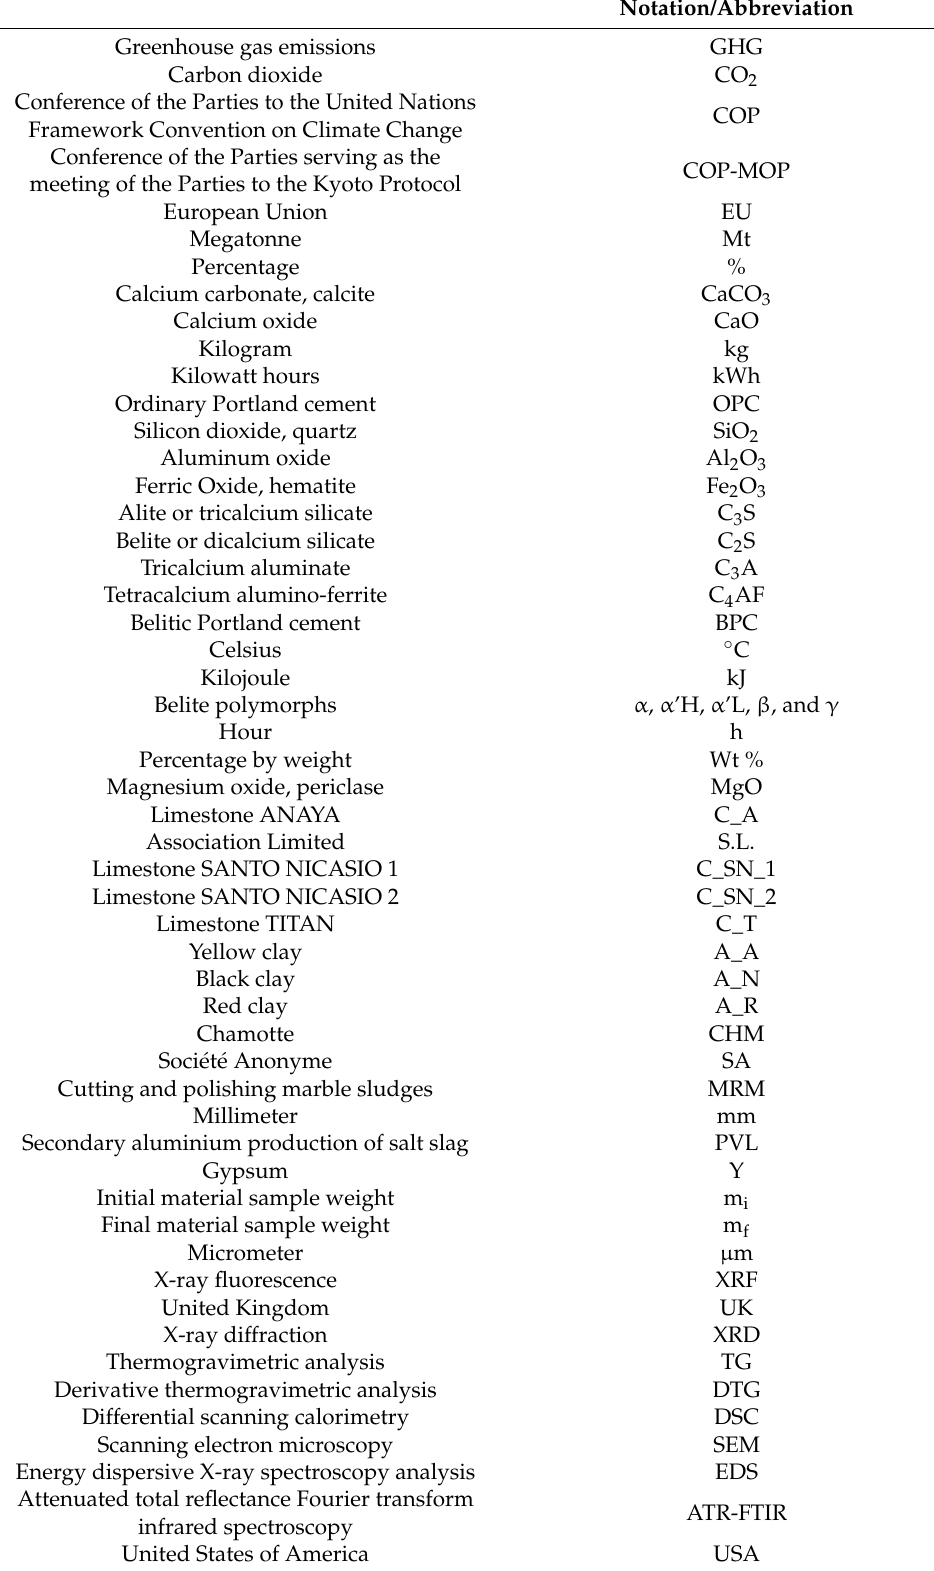
Table A1. List of notations/abbreviations ordered according to their occurrence in the